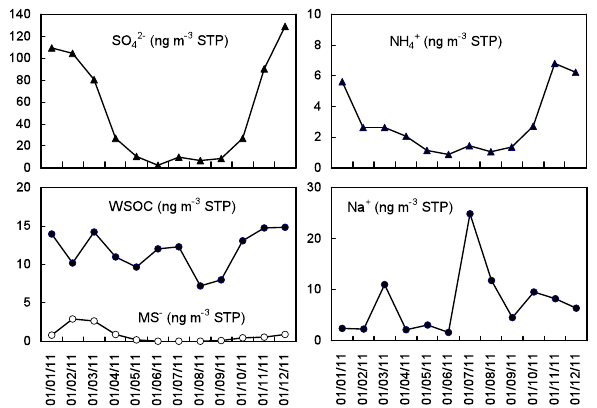
Fig. 4. Year-round bulk aerosol composition observed at Concordia in 2011. Note the higher sodium values in winter than in summer and the well-marked maximum of sulfate and MS − (CH 3 SO − summer (see discussions in Sect.